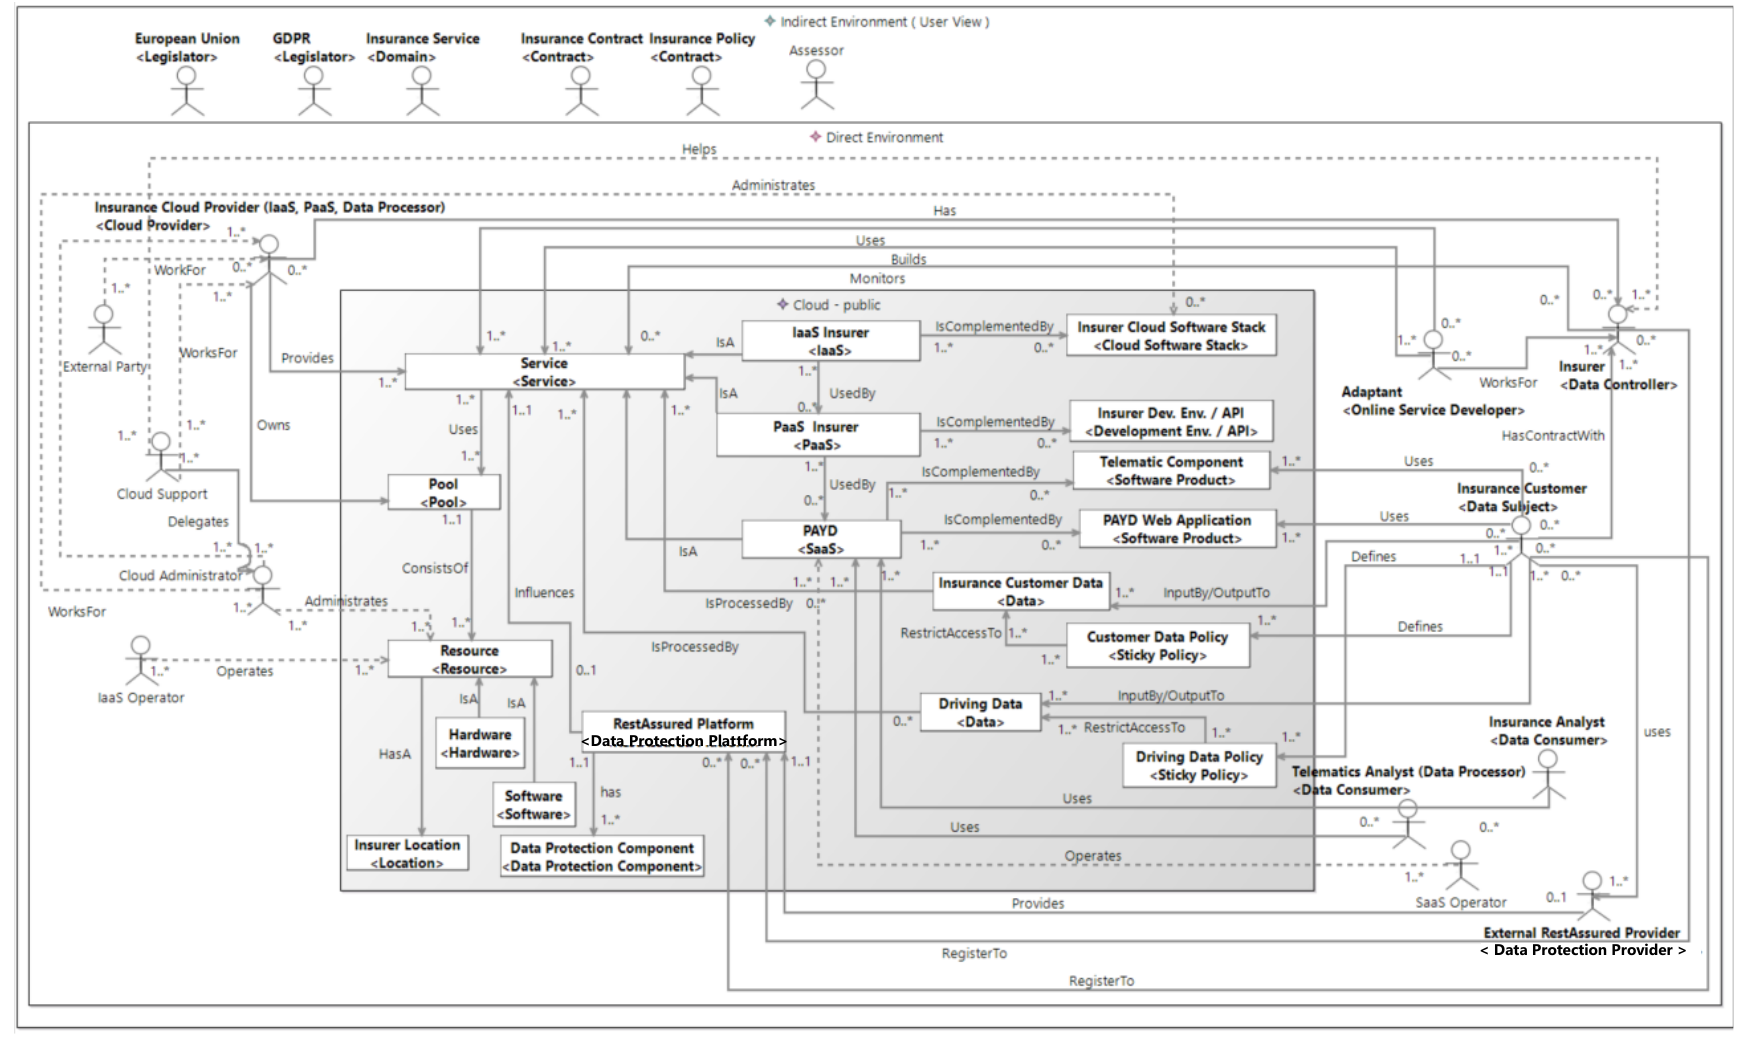
Figure 5. Instantiation of the ReAs-CSAP for the use case PAYD